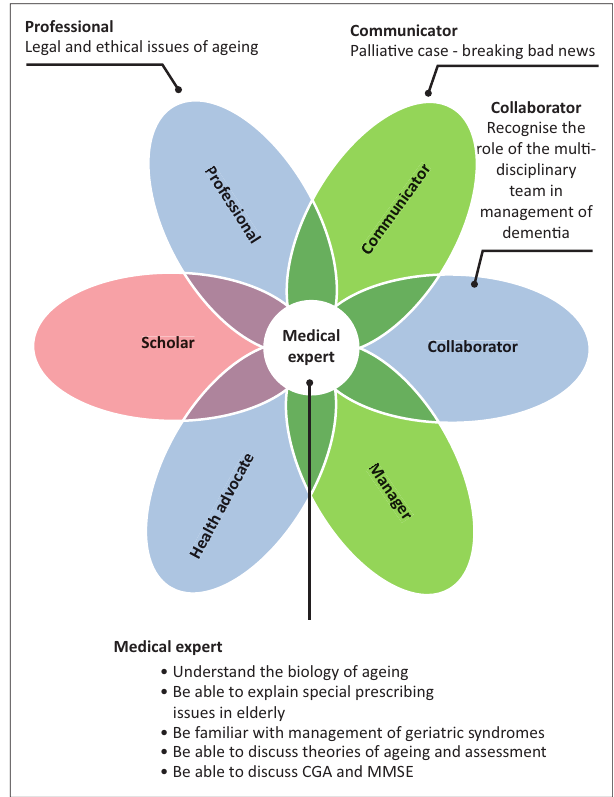
FIGURE 1: Mapping geriatric competencies as interpreted through the CanMEDS